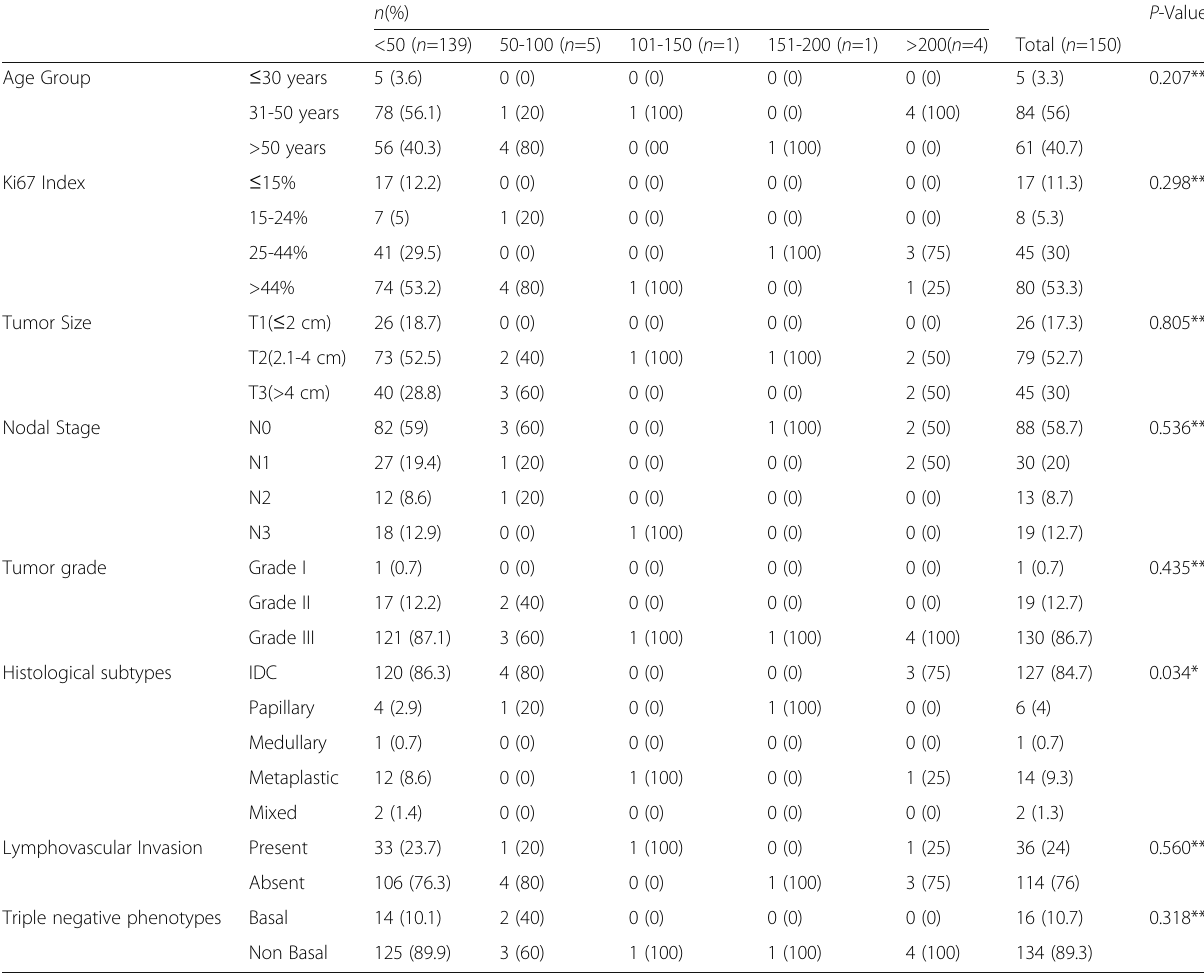
Table 2 Association of EFGR expression with clinicopathologic features of triple negative breast cancer using different EGFR score